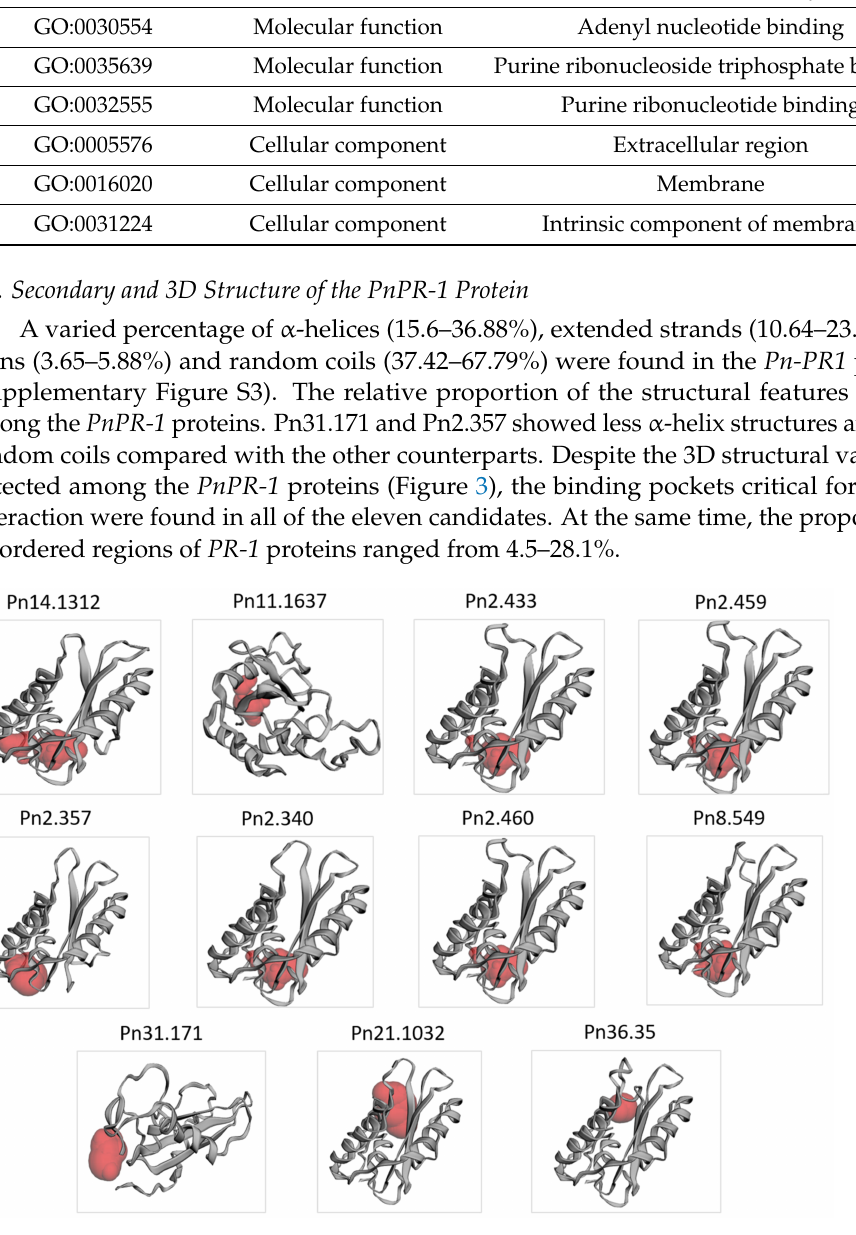
Figure 3. The predicted 3D structures of PnPR-1 proteins generated using the Phyre2 server and binding pockets identified by the CASTp 3.0 server (red